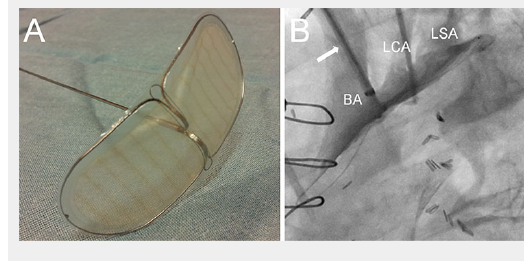
Figure 4 Example of an embolic protection device. The Embrella embolic deflector (A, Embrella Cardiovascular Inc, Wayne, PA) is introduced through the right radial artery to protect the brachiocephalic artery (BA), the left carotid artery (LCA) and the left subclavian artery (LSA) during the